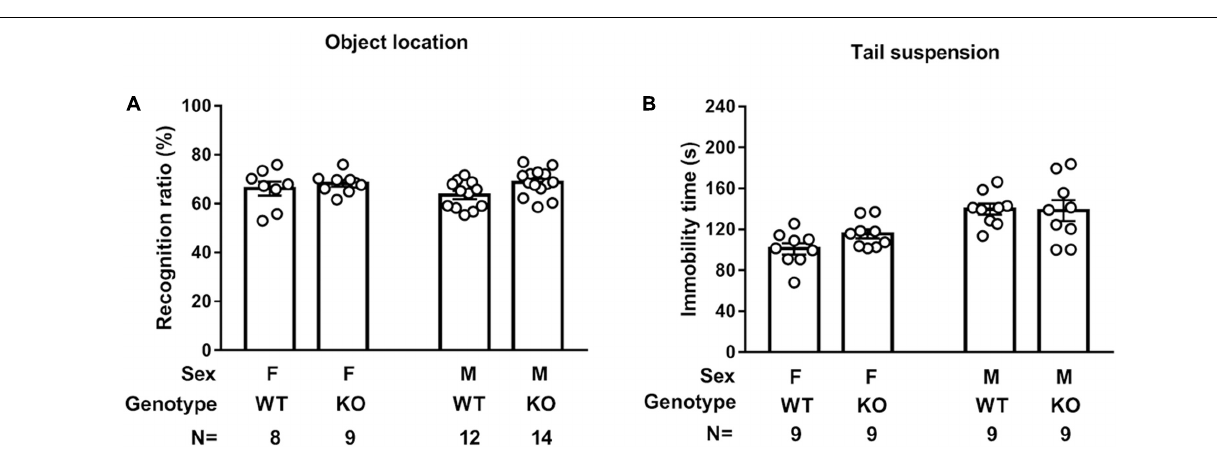
FIGURE 7 | SEPT14 KO and object location memory and tail suspension immobility time. (A) Four groups of mice showed indistinctive recognition ratios in the object location test session. (B) Male mice exhibited greater immobility time than female mice in the tail suspension task. SEPT14 KO did not affect such immobility time in either sex. Bar and error bar represent group mean and SEM,